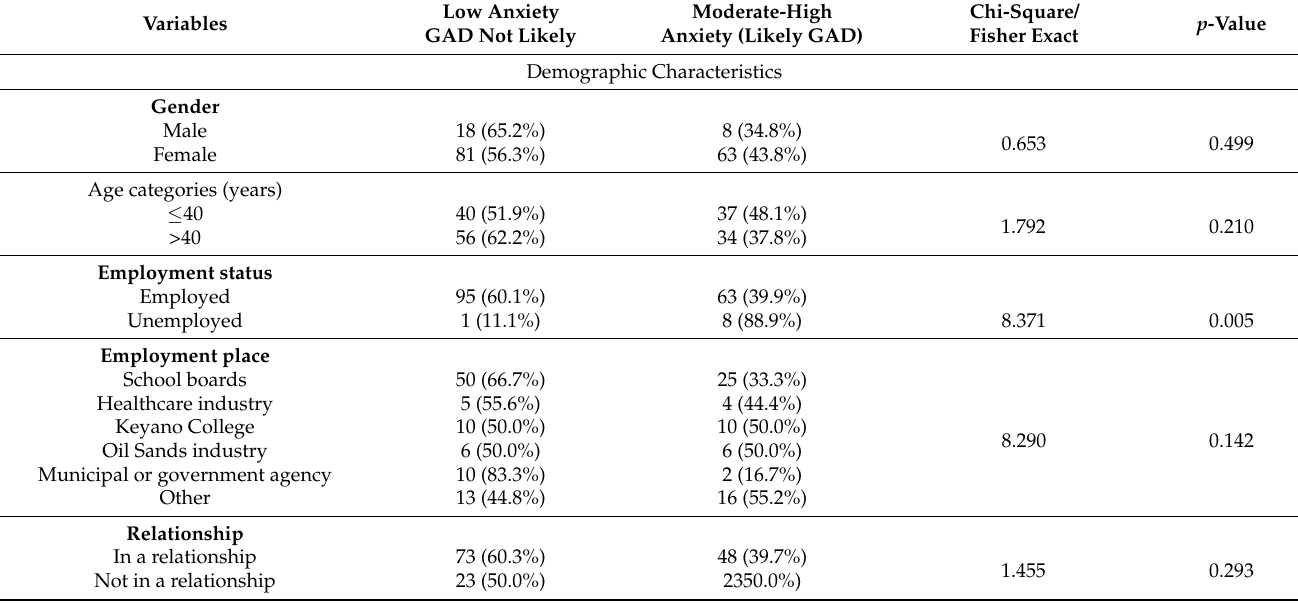
Table 2. Chi-squared test of association between the demographic, clinical antecedents, and General- ized Anxiety